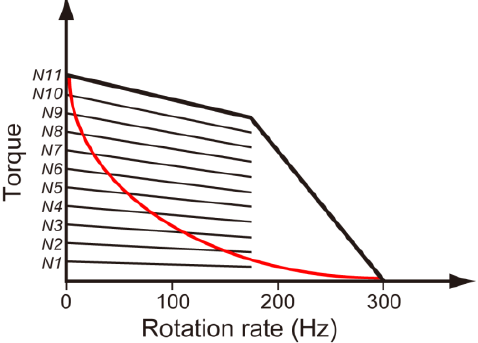
Figure 6. Torque-speed curves of the wild-type (black line) and MotB(∆72–100) mutant motors (red line). Torque-speed curves of the wild-type motor with different number of stator units are indicated ( N – N 1 11